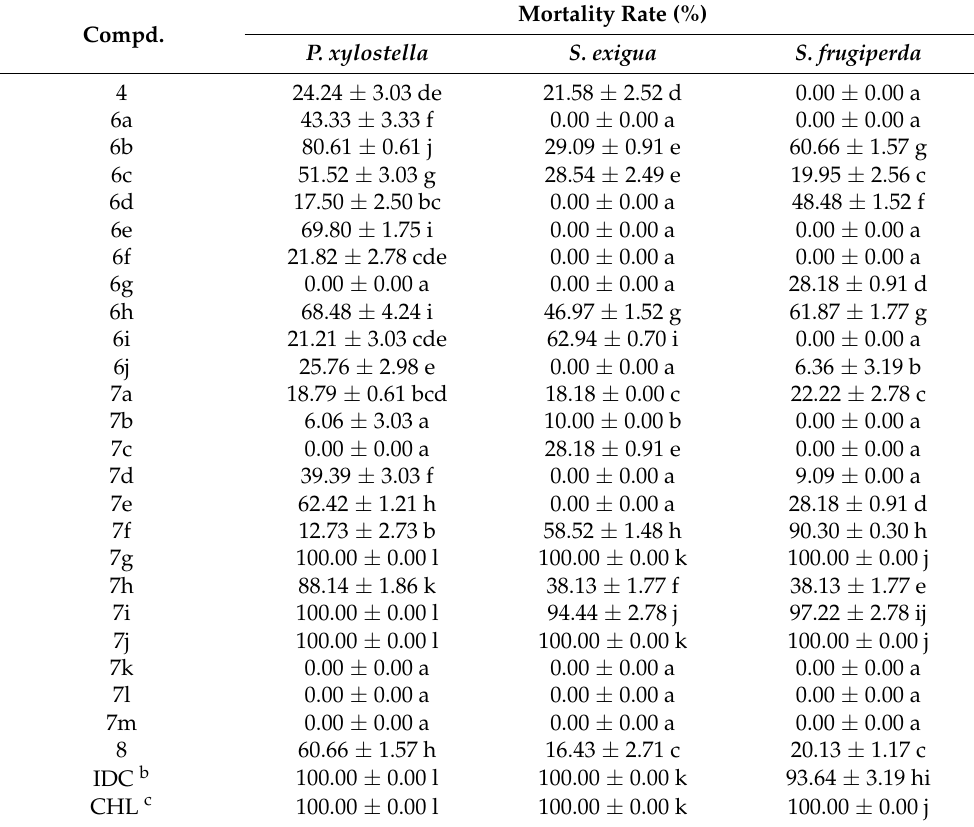
Table 1. Insecticidal activities of the tested compounds against three Lepidoptera pests at 100 mg/L after treatment 48 h a . Compd.